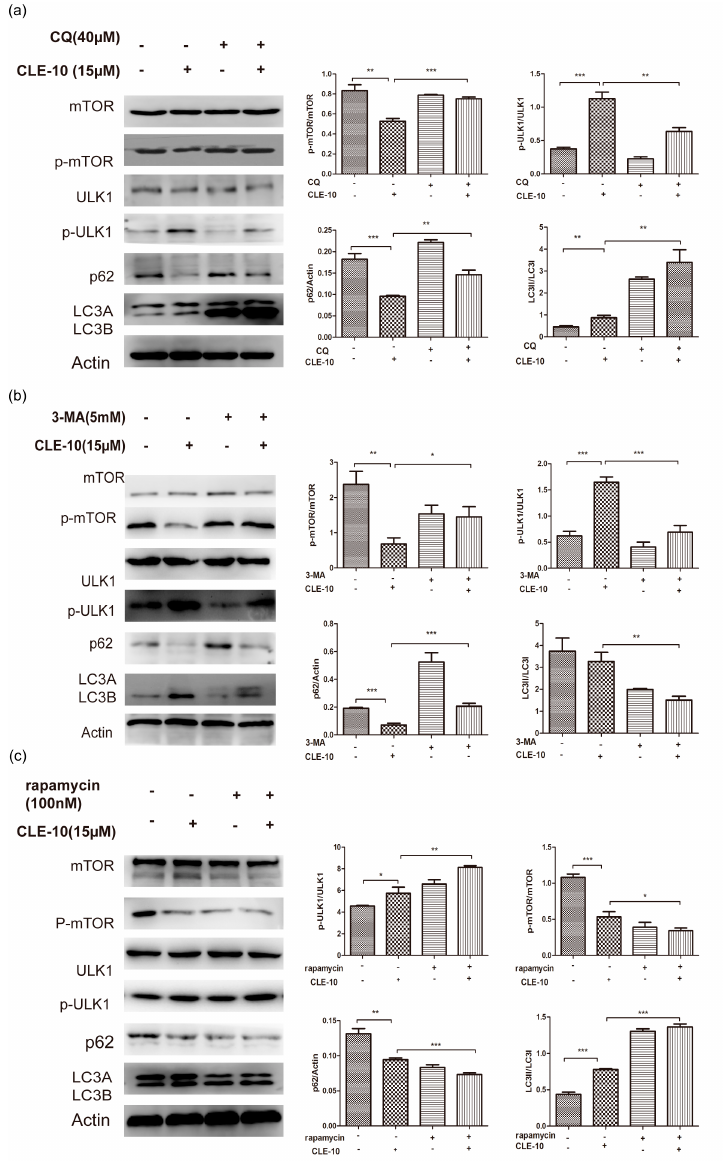
Figure 7. Effect of CLE-10 on autophagy-related proteins LC3-I/II, p-ULK1, ULk1, p62, mTOR, and p-mTOR were detected with and without autophagy inhibitor 3-MA, CQ, as well as the mTOR agonist rapamycin by Western blot analysis. ( a ) CLE-10 was used in combination with CQ. ( b ) CLE-10 was used in combination with 3-MA. ( c ) CLE-10 was used in combination with rapamycin. (* p < 0.05, ** p < 0.01, *** p < 0.001 compared with the control group or the CLE-10 group).